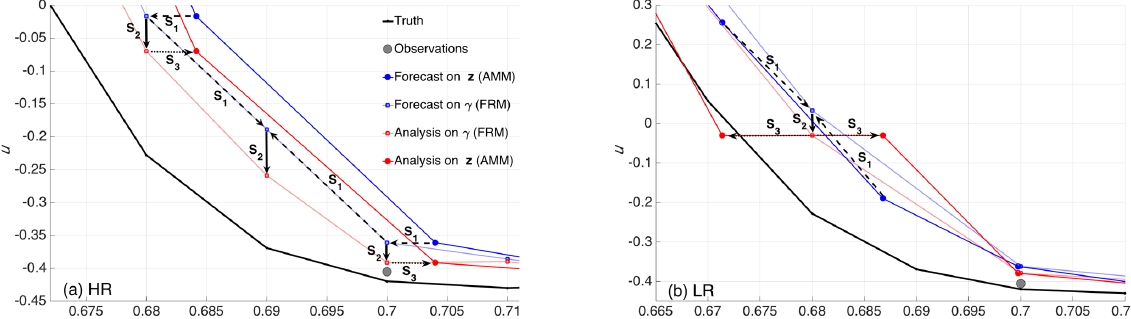
Figure 4. Schematic illustration of the DA cycle on the high-resolution (a) and low-resolution (b) fixed reference mesh. On the legend, dark and light blue and red lines are forecast and analysis on adaptive moving mesh (AMM) and fixed reference mesh (FRM), respectively. Observations (gray circles) are sampled from the truth (black line). When following the arrows, S 1 is the mapping the adaptive moving mesh onto the fixed reference mesh, S 2 is update of the ensemble member and S 3 is backward mapping onto the adaptive moving mesh (see Fig.